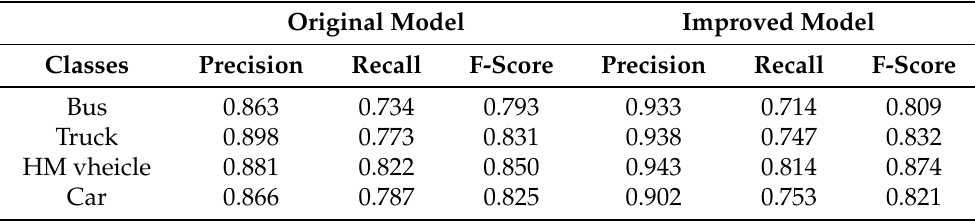
Table 2. Performance of per class detection between the original and the improved model.